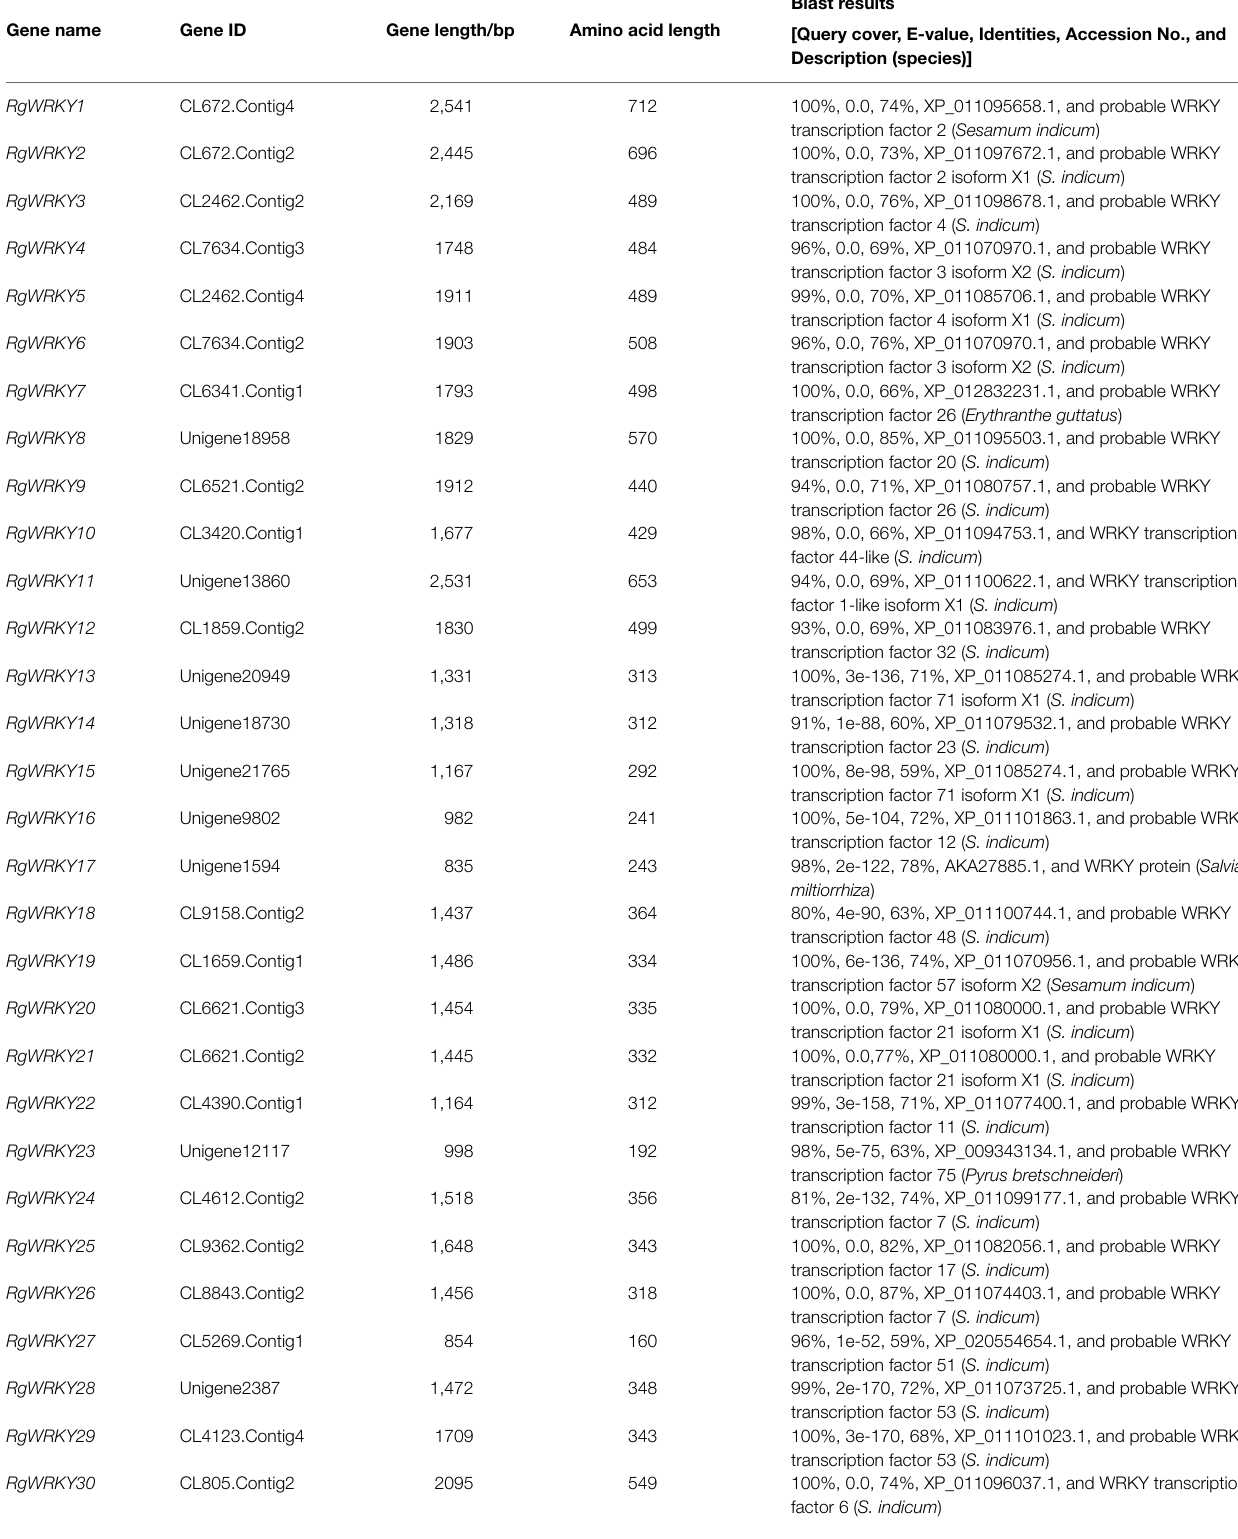
TABLE 1 | WRKY genes identified in R. glutinosa